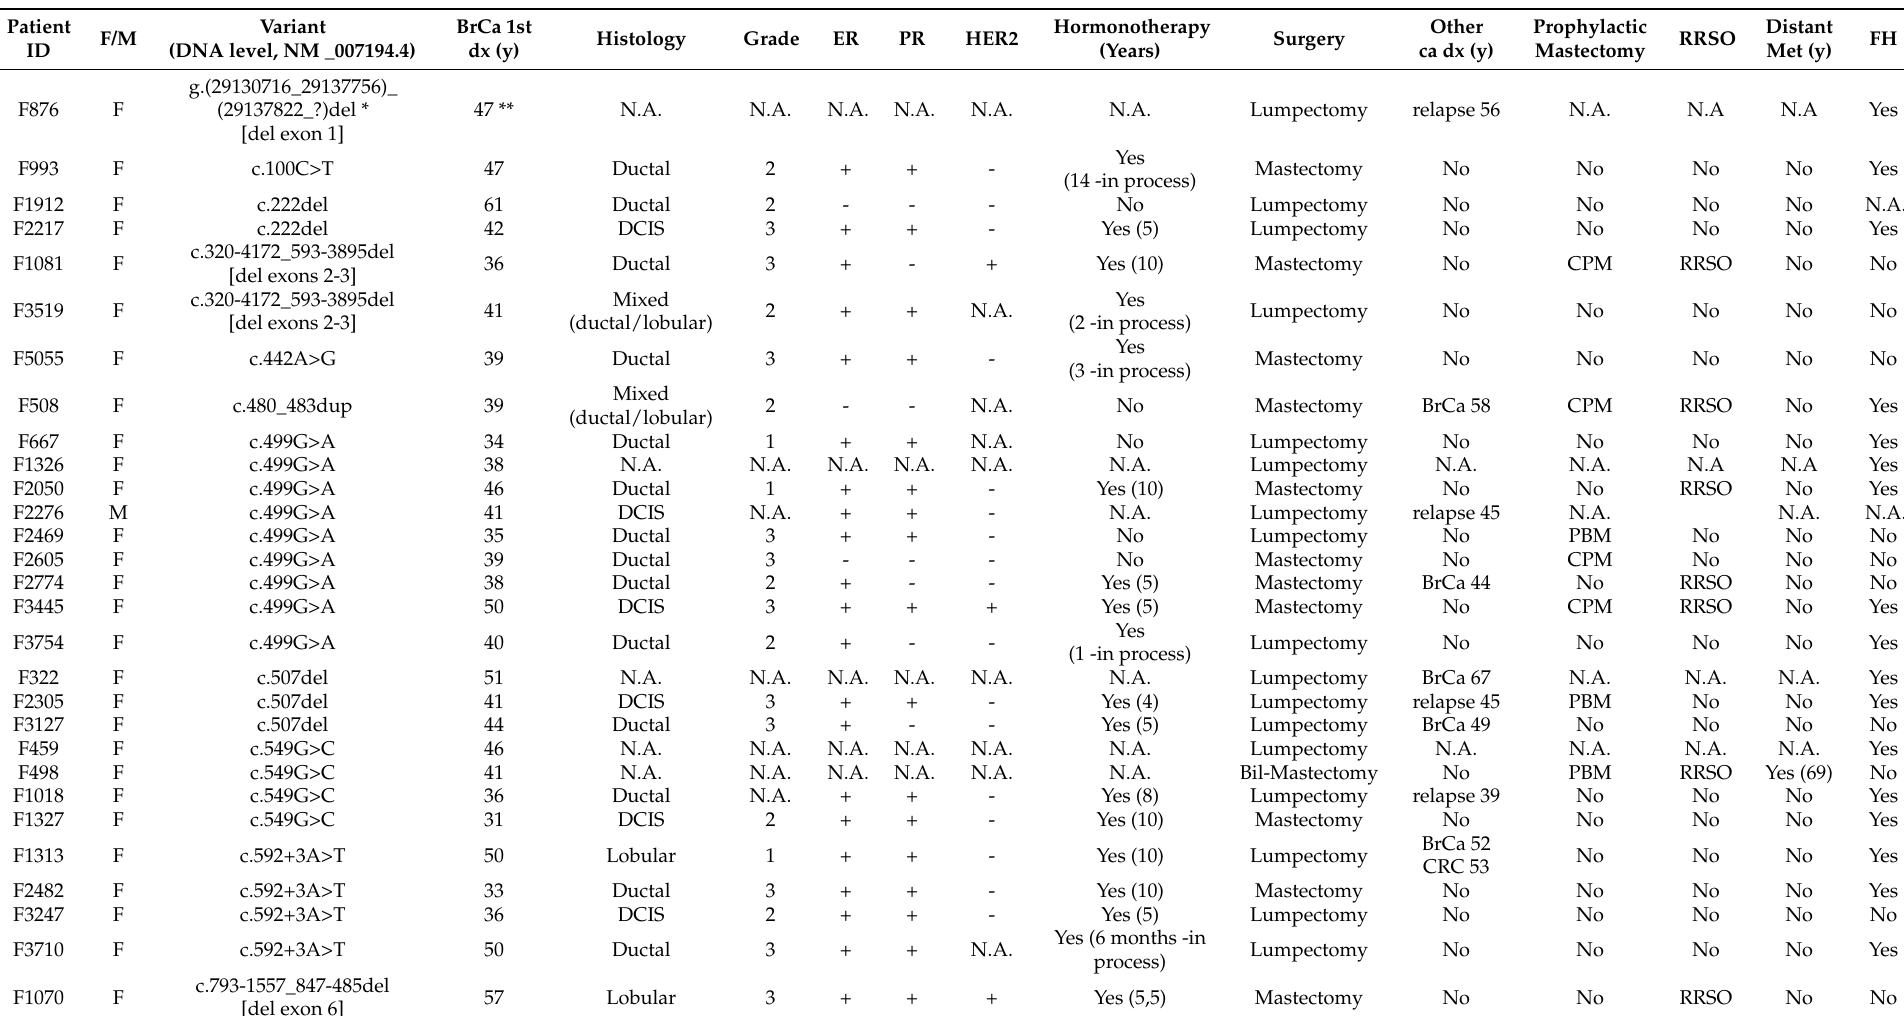
Table 1. Pathogenic CHEK2 variants identified in breast cancer cases, along with patients’ clinical and histopathological